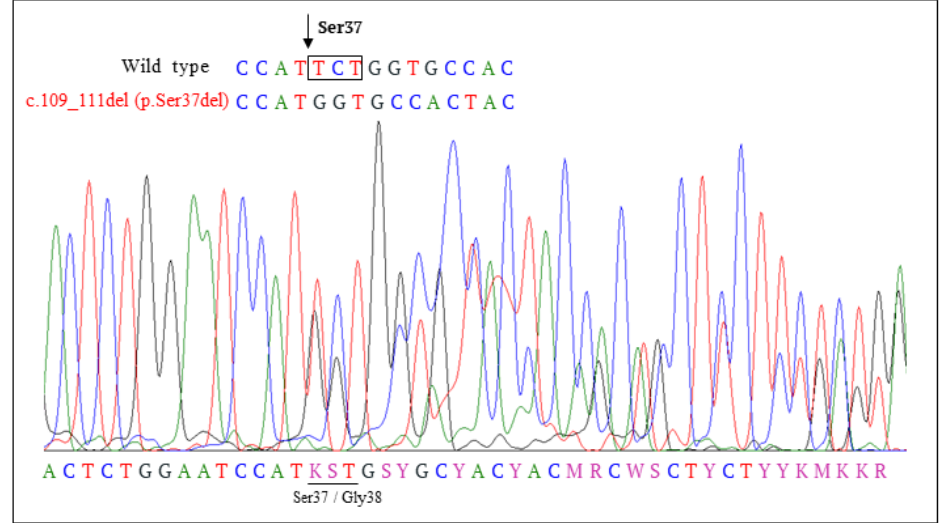
Figure 2. DNA sequencing of CTNNB1 exon 3 from a tumor specimen. Sanger DNA sequencing showed the deletion c.109-111del, resulting in deletion of a TCT codon in the tumor sample (p.Ser37del).